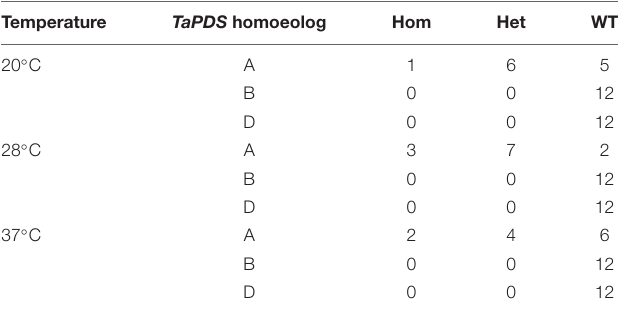
TABLE 1 | Genotypes of mutations in GE1.2 grown under three different temperatures for 7 days. Temperature TaPDS homoeolog Hom